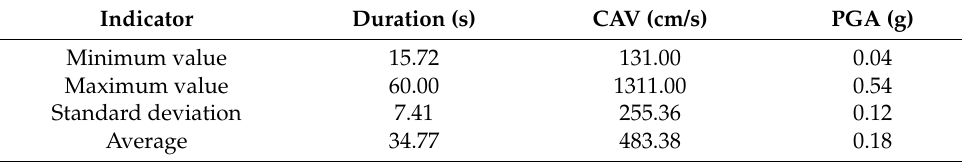
Table 5. Statistical values of the duration, CAV and PGA of the earthquake